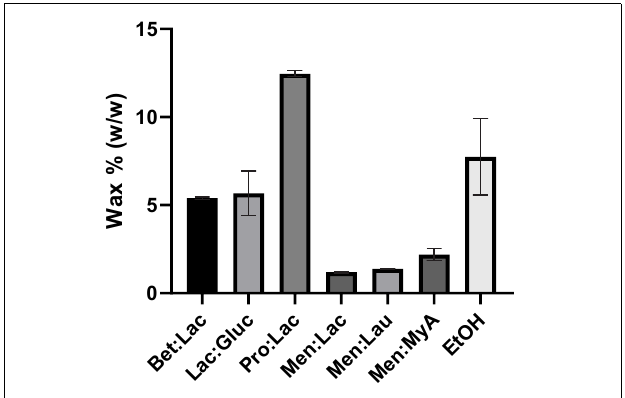
FIGURE 6 | Quantification of the total chlorophyll ( µ g/g extract) present in the obtained hemp extracts before and after